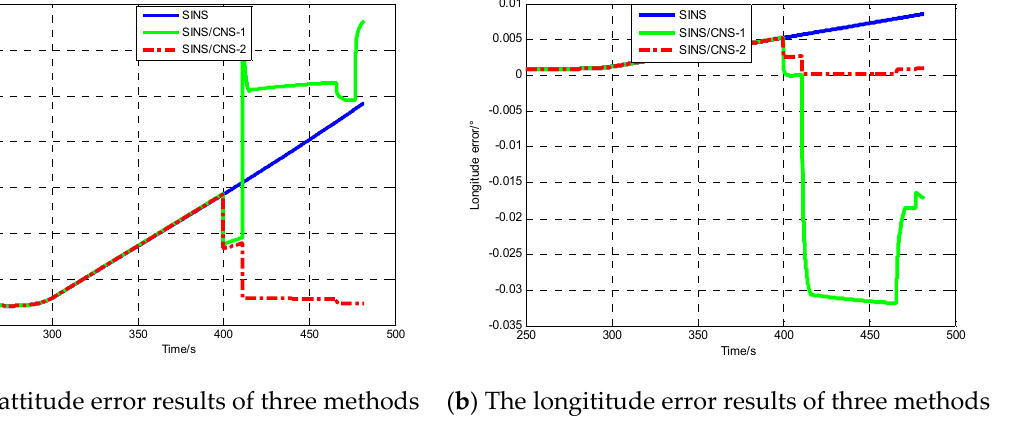
( c ) The altitude error results of three methods ( d ) The pitch error results of three methods